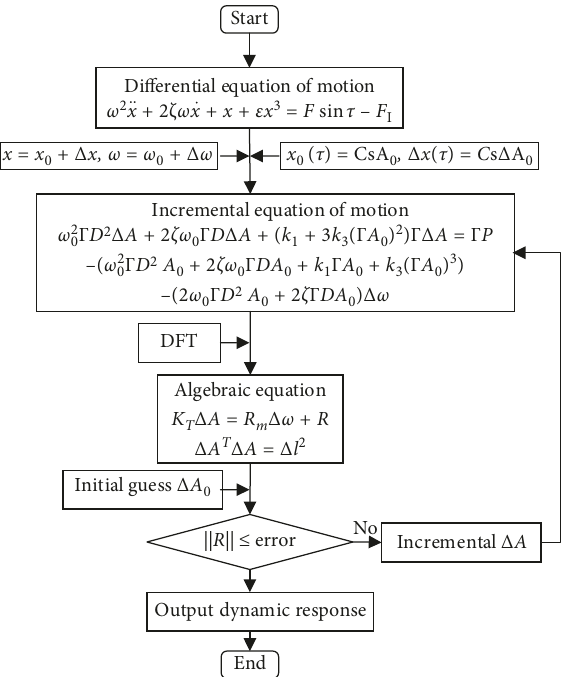
Figure 5: Algorithm of the MIHBM with DFT.